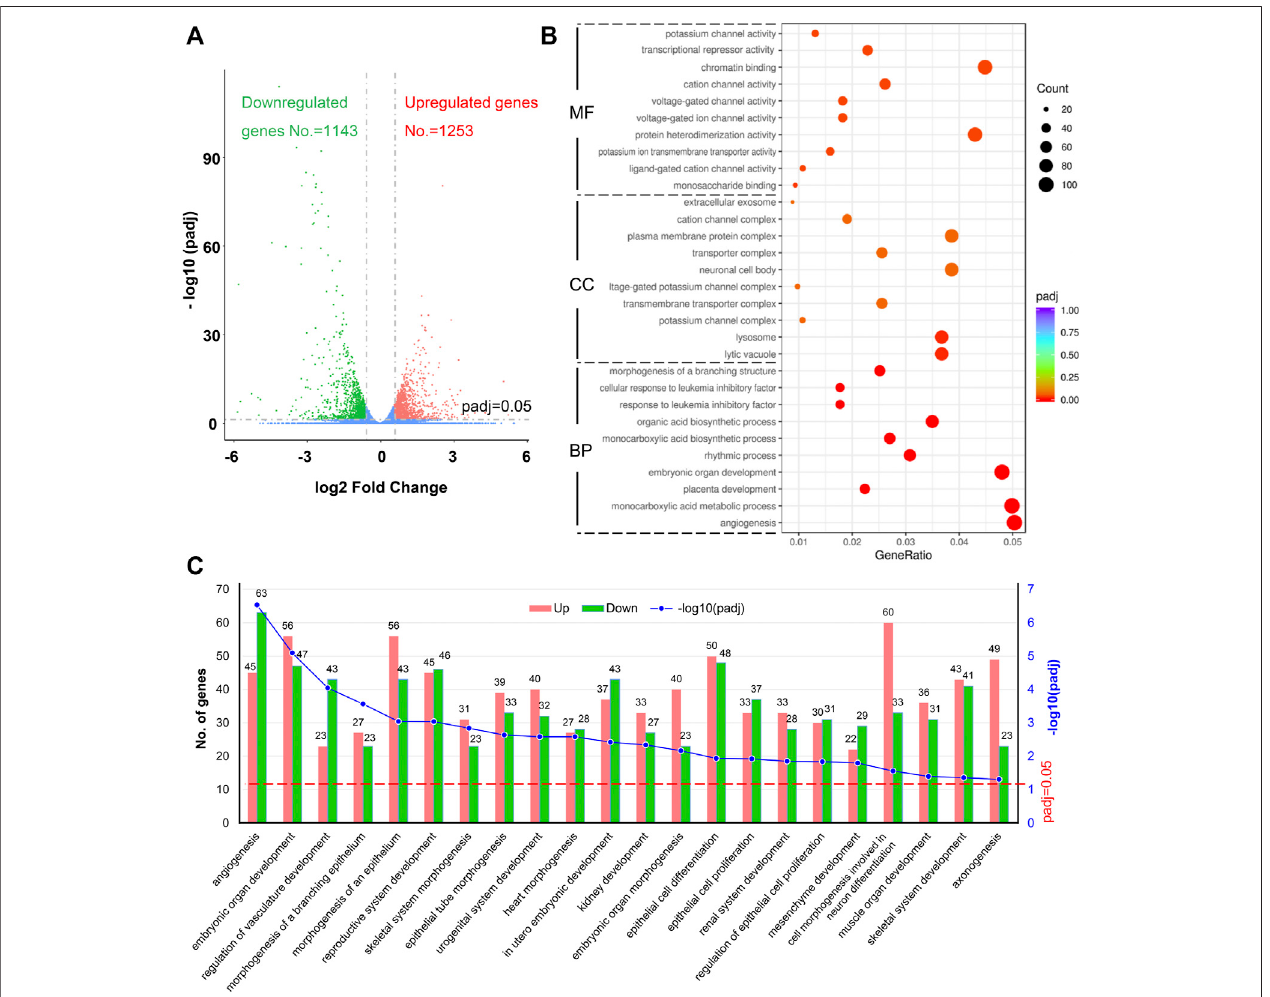
FIGURE 2| Identi fi cation ofDEGs and GO enrichment analysis. (A) Volcano plot ofDEGs. Upregulated genes(padj < 0.05 and fold change > 1.5) are shown in red, and downregulated genes are shown in green (padj < 0.05 and fold change < 0.66). padj, adjusted p value. (B) Top 10 enriched GO terms of BP, CC, and MF sorted accordingtopadjvalue.GeneRatioindicatestheratioofenrichedDEGsovertotalDEGs.ThesizeandcolorofthedotindicatethecountofDEGsenrichedintheGOterm and thesigni fi cance,respectively. (C) Signi fi cantly enriched BPterms related to embryonic development,which wereenriched bymore than 50 DEGs, are shown. The numbers of upregulated and downregulated DEGs related to each BP term are indicated.